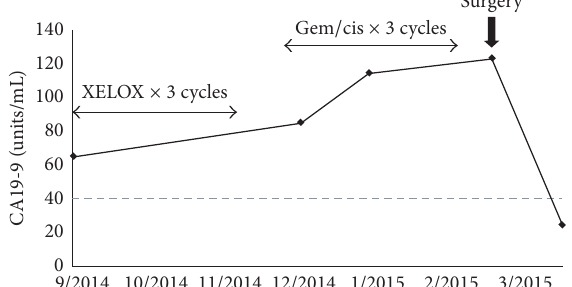
Figure 4: The serum CA19-9 level kept rising in spite of three cycles of XELOX and three cycles of gemcitabine/cisplatin and returned to the reference range following surgical resection of the abdominal wall